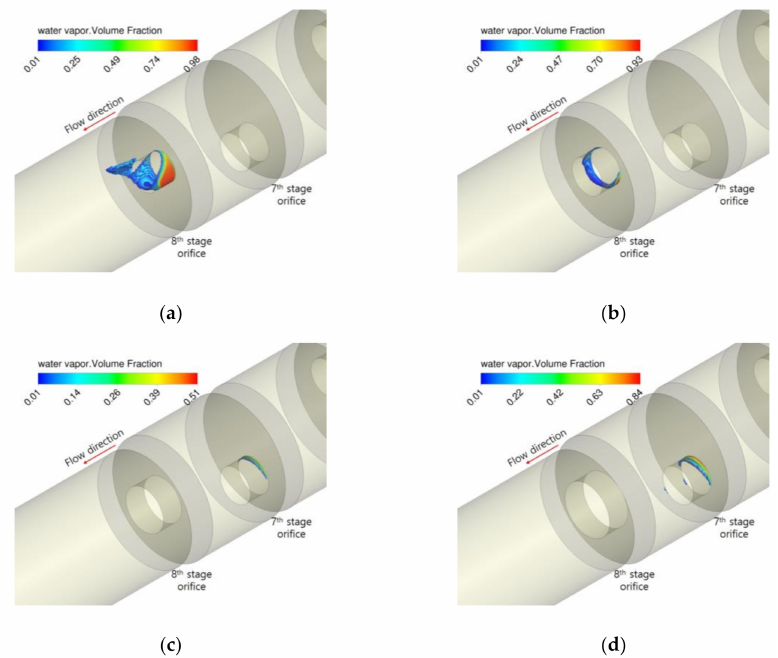
Figure 19. Iso-volume of vapor volume fraction depending on the size of the hole diameter (d 8 ) in the eighth orifice stage: ( a ) d 8 /d = 0.84; ( b ) d 8 /d = 1.0 (original case); ( c ) d 8 /d = 1.24; and ( d ) d 8 /d =